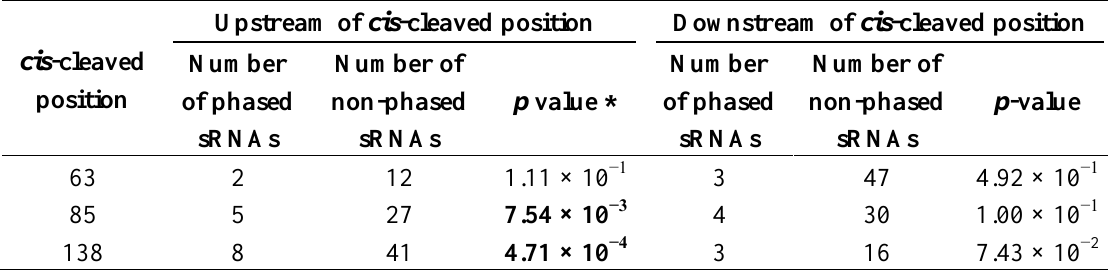
Table 2. Phased patterns set by different cis -cleavages.